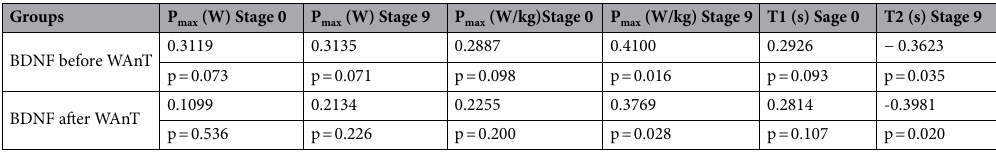
Table 7. Correlation BDNF with WAnT parameters before and after 9 week training.